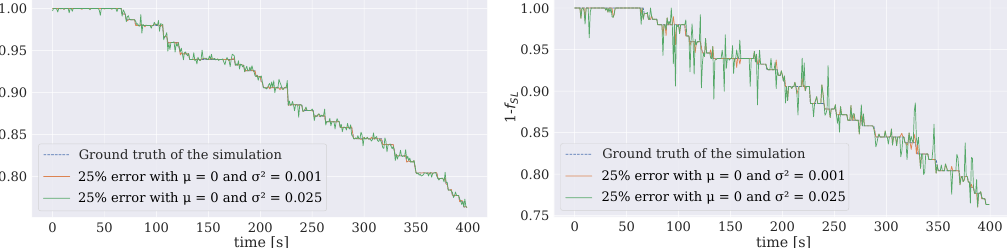
Figure 12. Observational robustness check for ANN in the boarding application domain for a 50% error ( left ) and 25% error ( right ) of an input sequence of 400